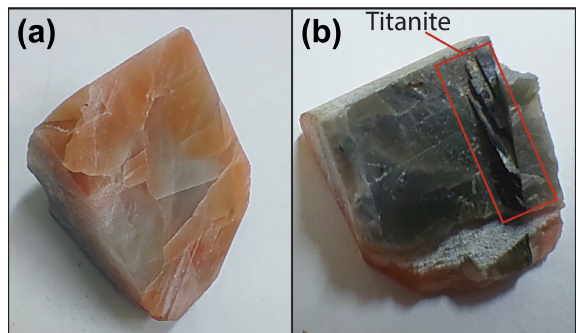
Figure A1. Images of MKED calcite. Panel (a) shows calcite chip from where the analysed sample was taken. Panel (b) shows un- derside of the same chip, where a large titanite crystal has been removed. Red box shows remnant fragments of titanite.